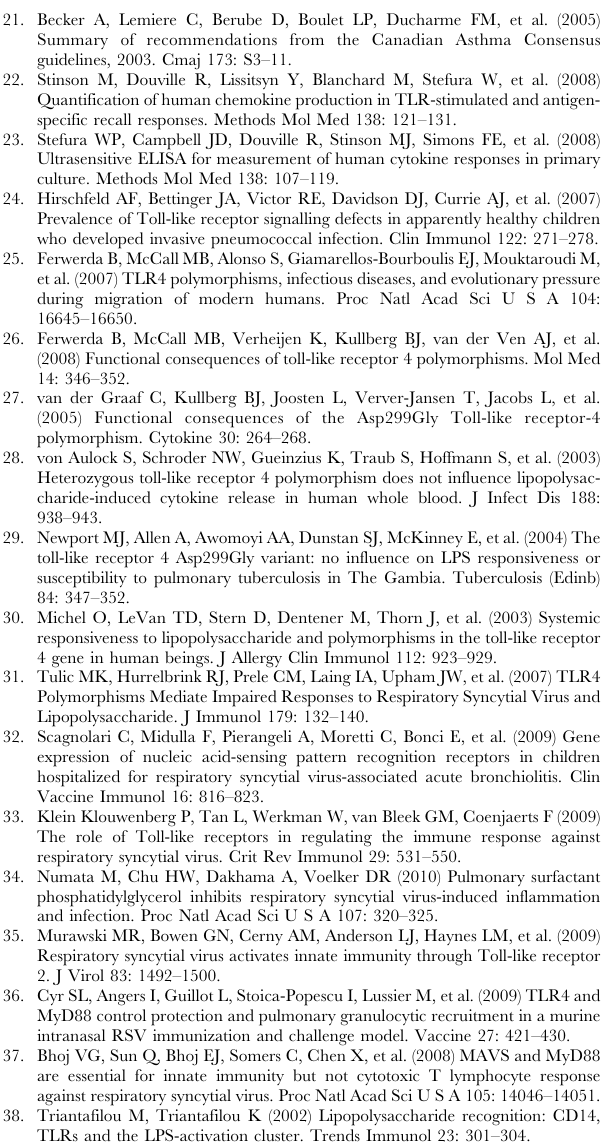
black bars represent median population responses, derived from individual children. * P=